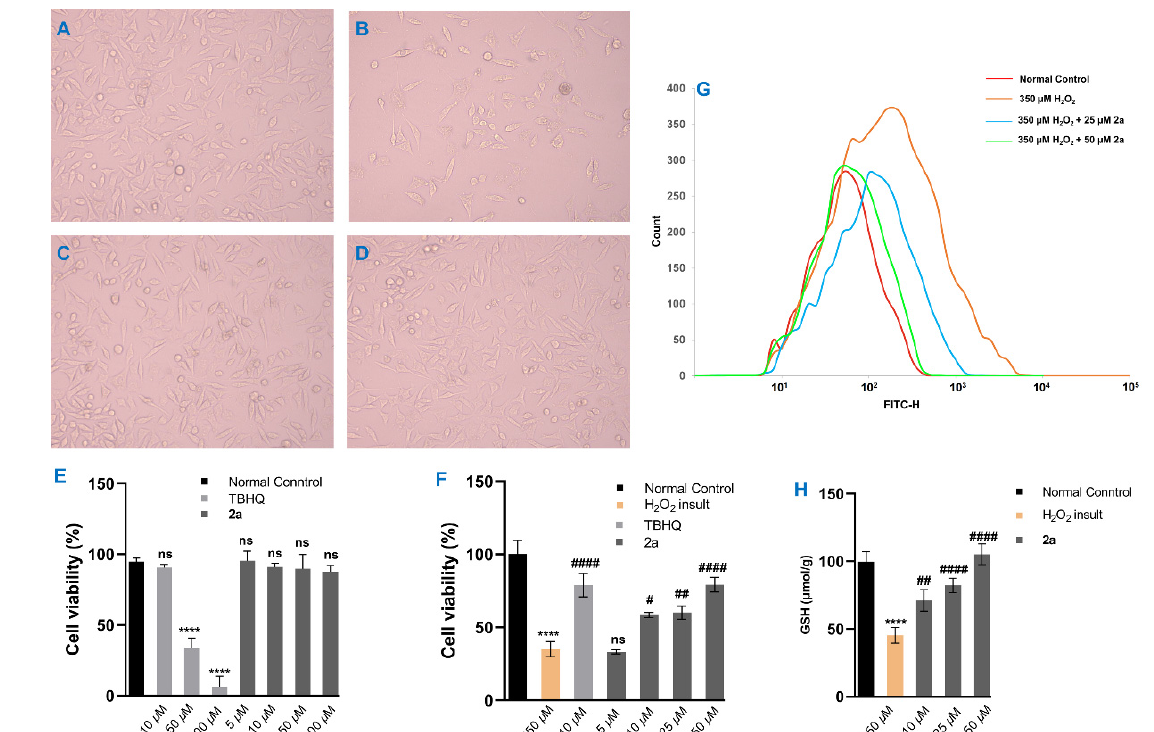
Figure 6. Cytoprotective activity of 2a towards H 2 O 2 insult SH-SY5Y cells. Morphological features of ( A ) normal control cells, ( B ) H 2 O 2 (350 µM) insult cells, ( C ) cells treated with H 2 O 2 (350 µM) + TBHQ (10 µM), and ( D ) cells treated with H 2 O 2 (350 µM) + 2a (50 µM); ( E ) viabilities of cells treated with TBHQ (10, 50, and 100 µM) or 2a (5, 10, 50, and 100 µM); ( F ) viabilities of cells treated with H 2 O 2 (350 µM), H 2 O 2 (350 µM) + TBHQ (10 µM), and H 2 O 2 (350 µM) + 2a (5, 10, 25, and 50 µM), respectively; ( G ) effects of 2a on intracellular ROS accumulation levels injured by H 2 O 2 ; ( H ) effects of 2a (10, 25, and 50 µM) on intracellular GSH contents injured by H 2 O 2 (350 µM). Values represent mean ± SD ( n = 3); **** P < 0.0001 vs. normal control group; # P < 0.05, ## P < 0.01, and #### P < 0.0001 vs. H 2 O 2 insult group (statistical analyses were performed using two-way ANOVA); ns means no